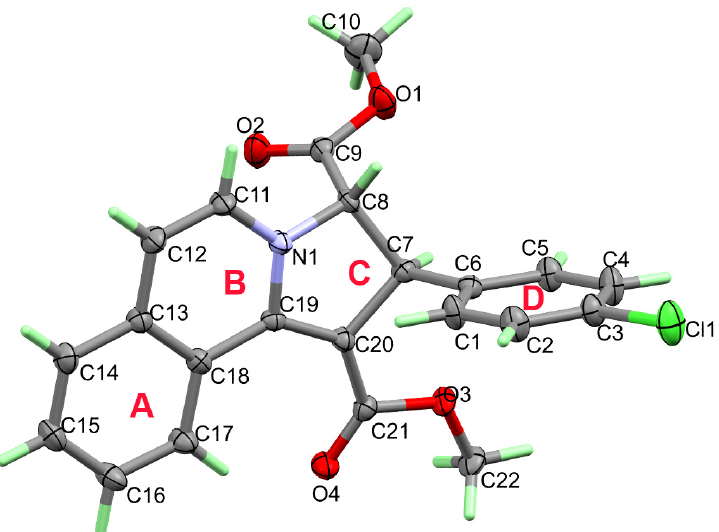
Figure 1. X-ray structure of 3 . Table 2. Bond lengths (Å) and angles (°) for 3 .